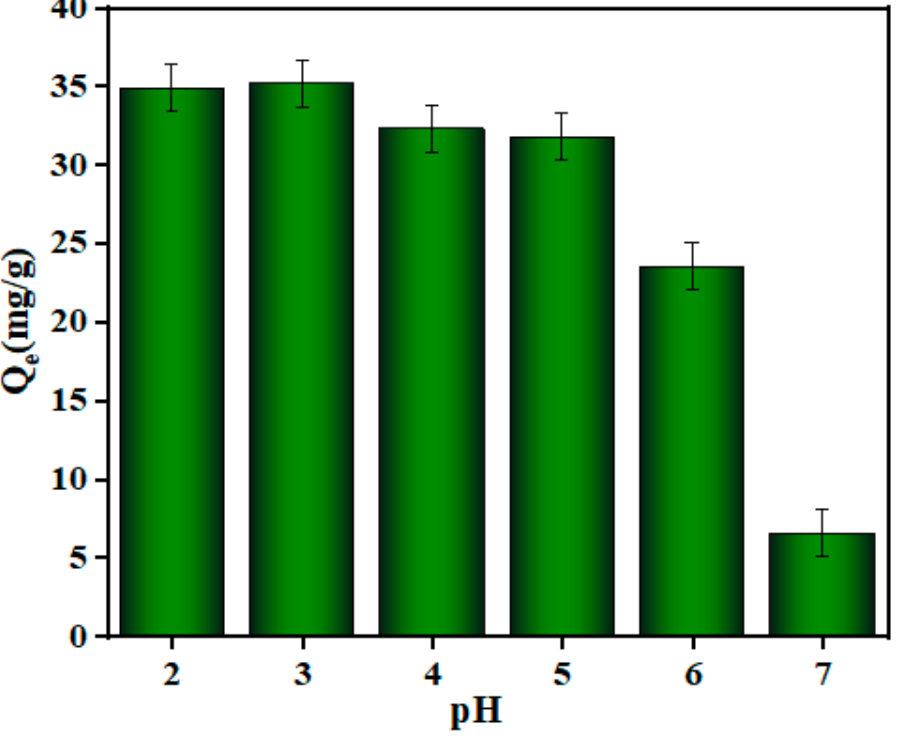
Figure 4. pH effect on Cr(VI) removal from water by CTAB@FZA (initial concentration = 20 mg/L, adsorbent dose = 0.5 g/L, pH = 2–7, time = 10 min, Temperature = 298